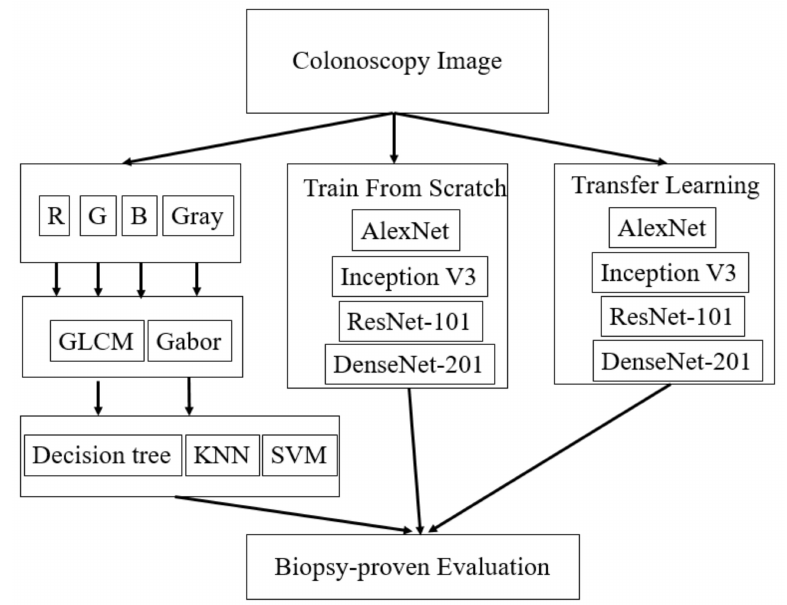
Figure 1. The flowchart of the polyp classification using colonoscopy image